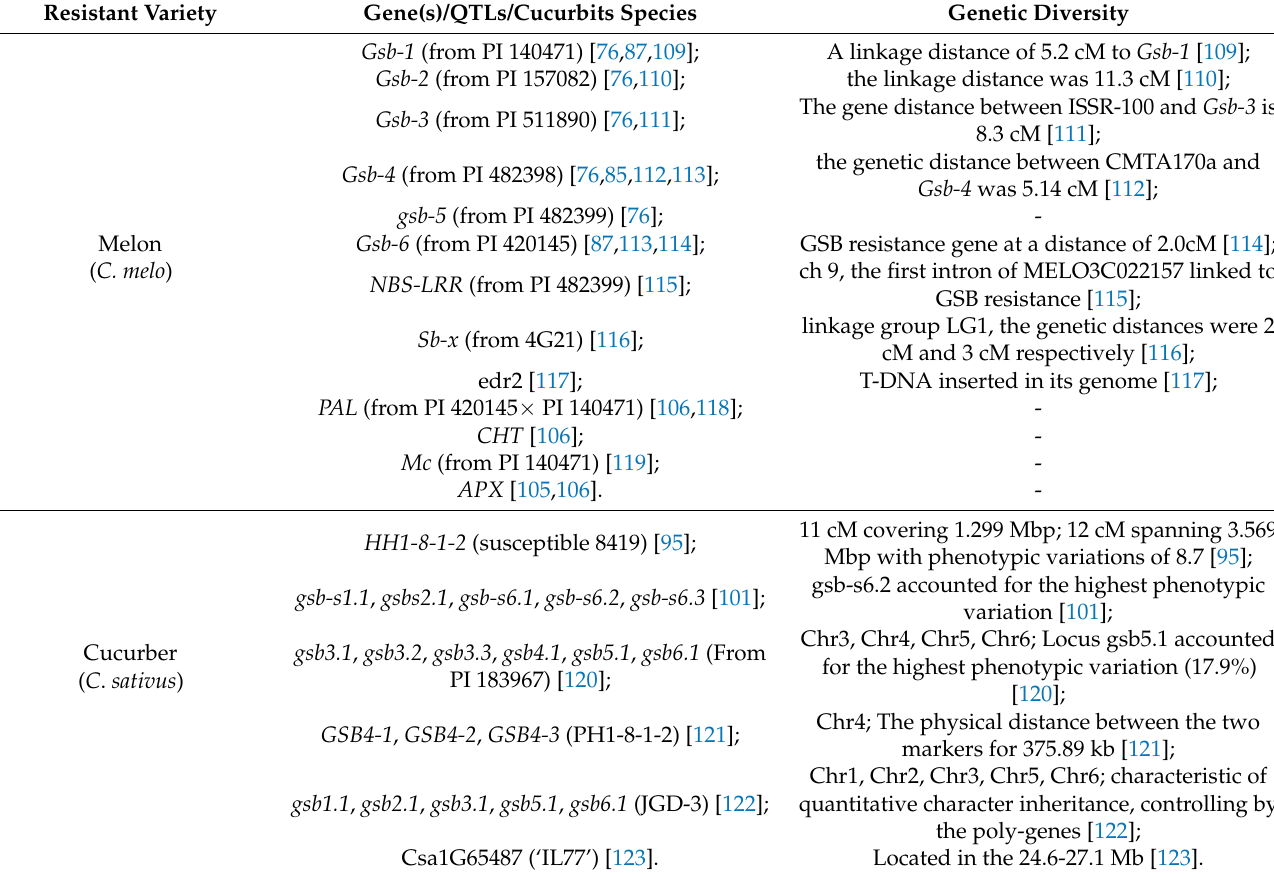
Table 4. Genetic diversity and resistance genes in some Cucurbitaceous